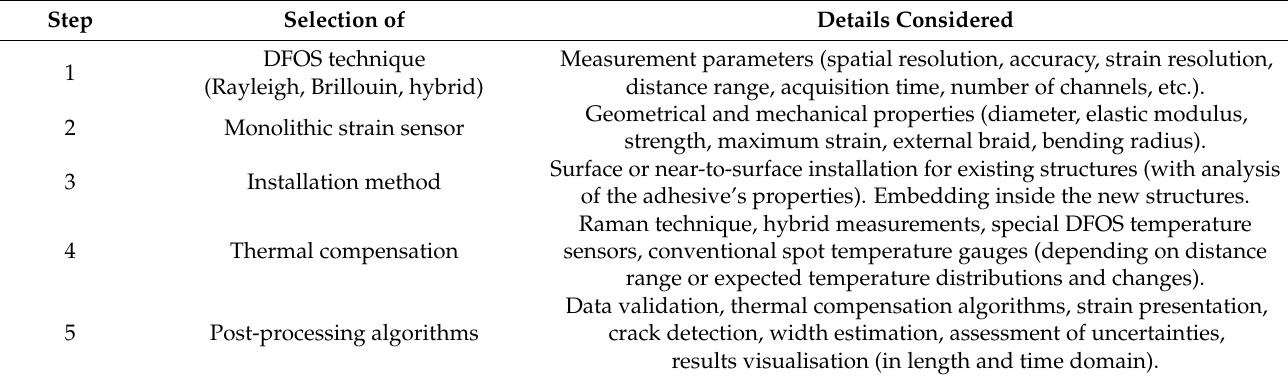
Table 2. Design procedure of DFOS system for crack monitoring in concrete structures.